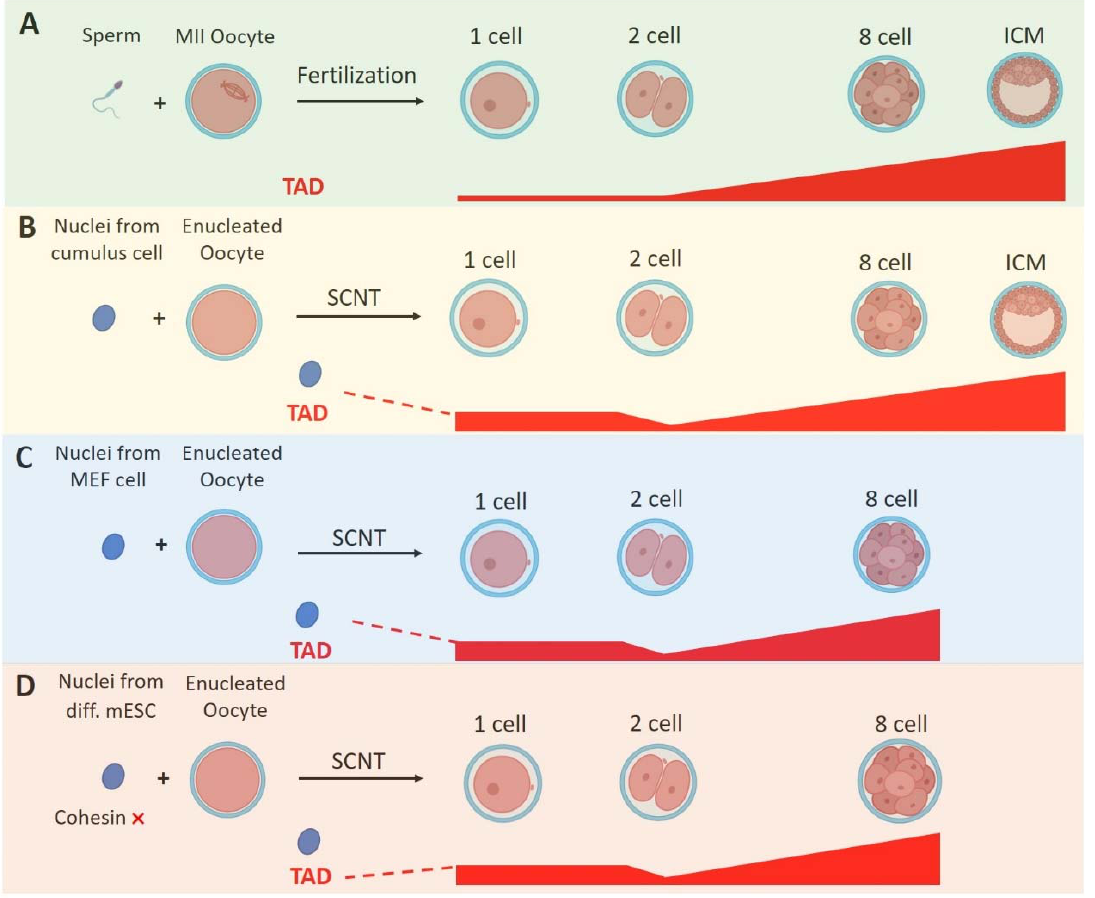
Figure 4. A schematic model comparing the reprogramming of chromatin organization in in vivo fertilized embryos and in vitro SCNT embryos. ( A ) The TAD dynamic during in vivo fertilized embryos development. ( B ) The TAD dynamics during SCNT embryo development. The SCNT embryos are derived from injecting the donor nuclei of terminally differentiated cumulus cells and enucleated oocytes. ( C ) The TAD dynamics in SCNT embryo development. The SCNT embryos derived from the donor nuclei of MEF cells and enucleated oocytes. ( D ) The TAD dynamics of SCNT embryos derived from cohesin-depleted donor nuclei.